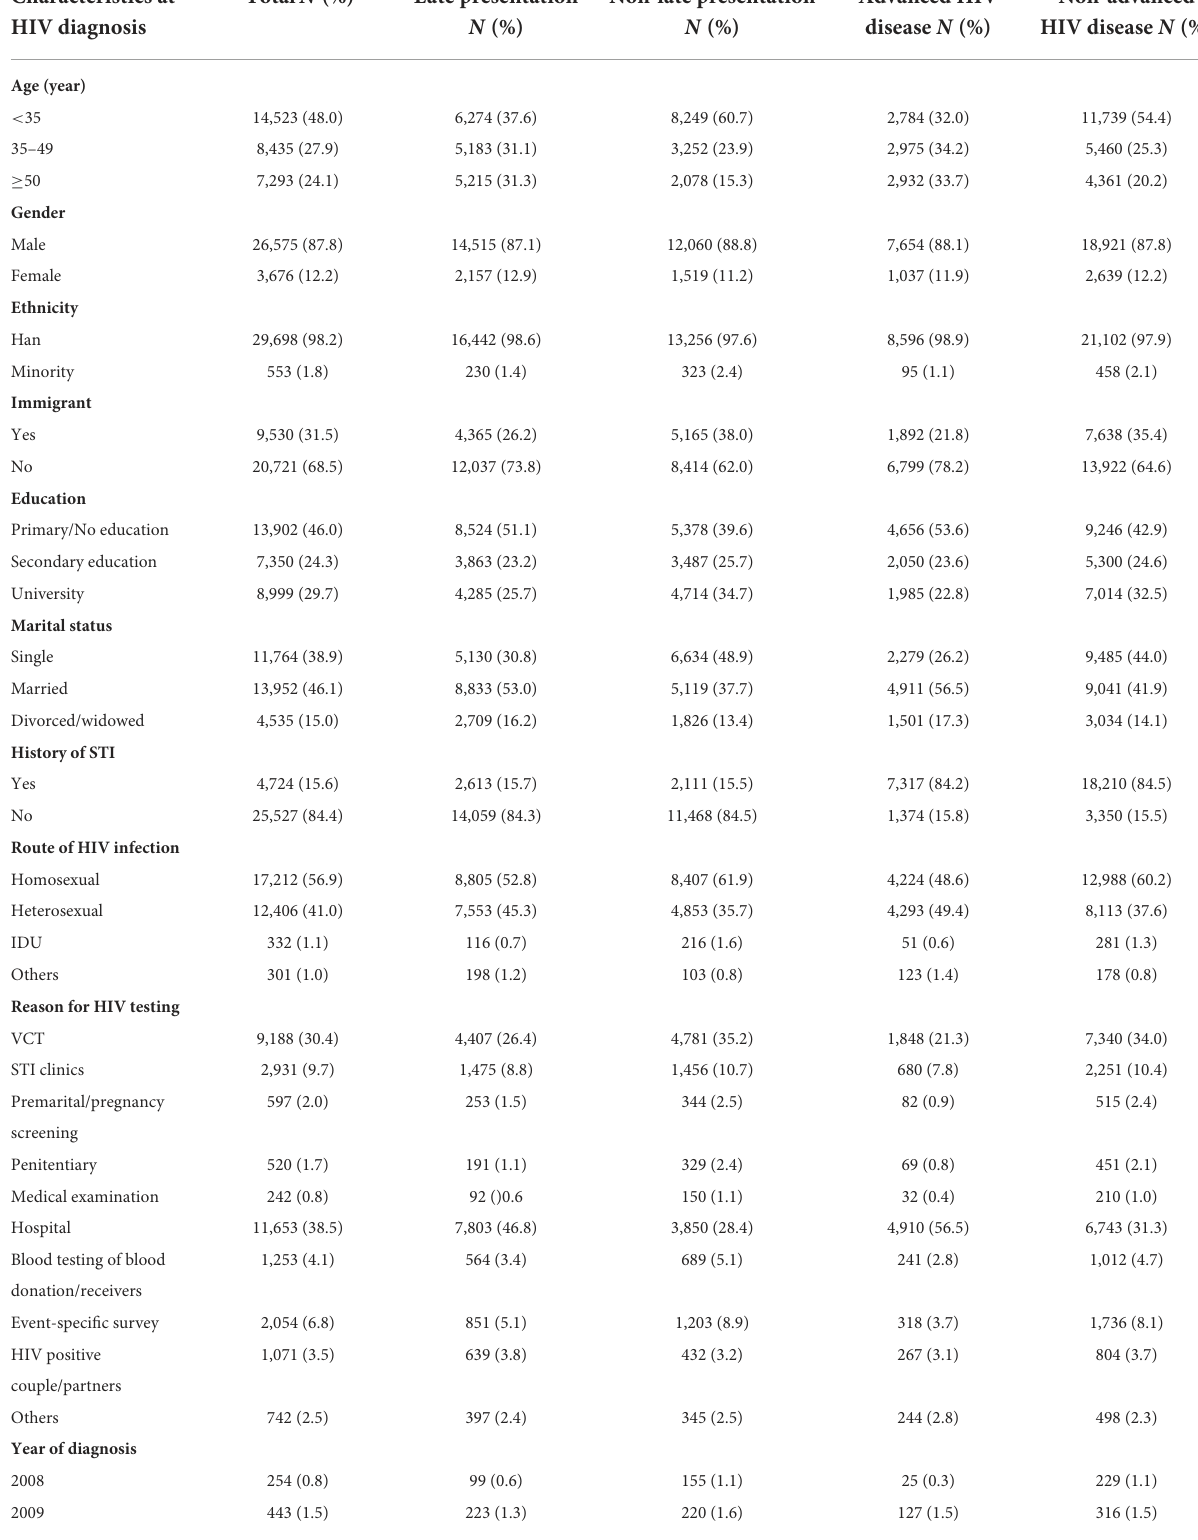
TABLE 1 Demographic and sociological features of the HIV/AIDS patients in China from 2008 to 2020. Characteristics at Advanced HIV